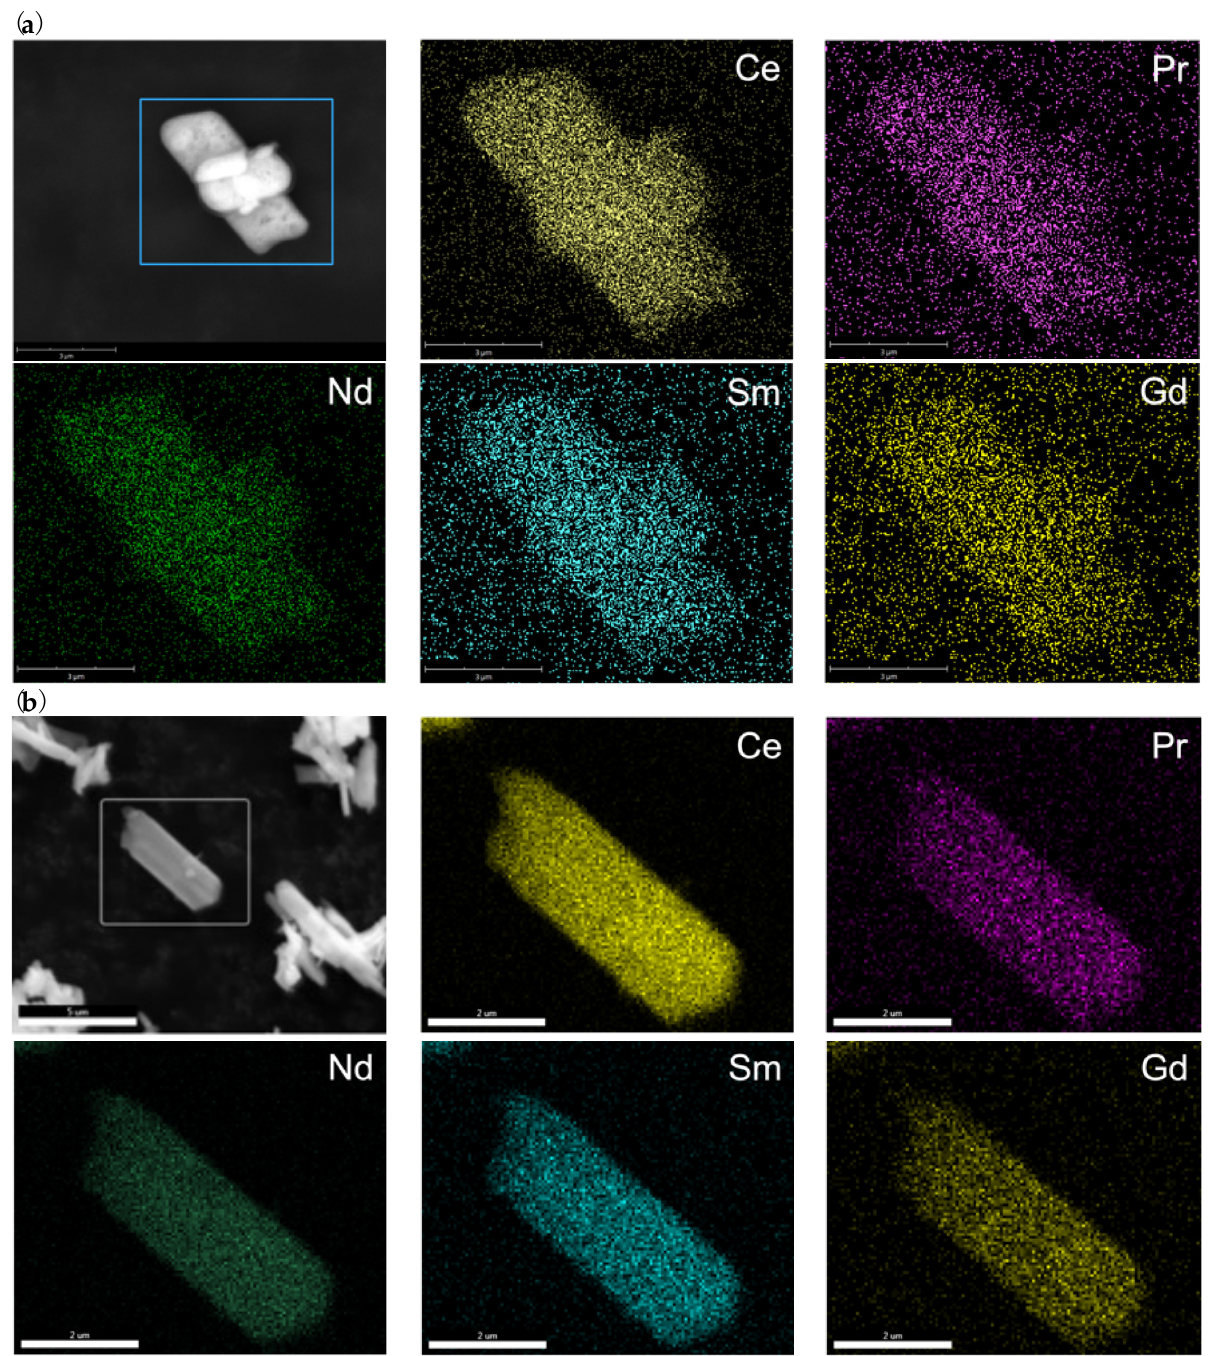
Figure 7. EDS data for ( a ) oxalate precursor and ( b ) calcined Ce HEO displaying homogeneous distribution of cations.